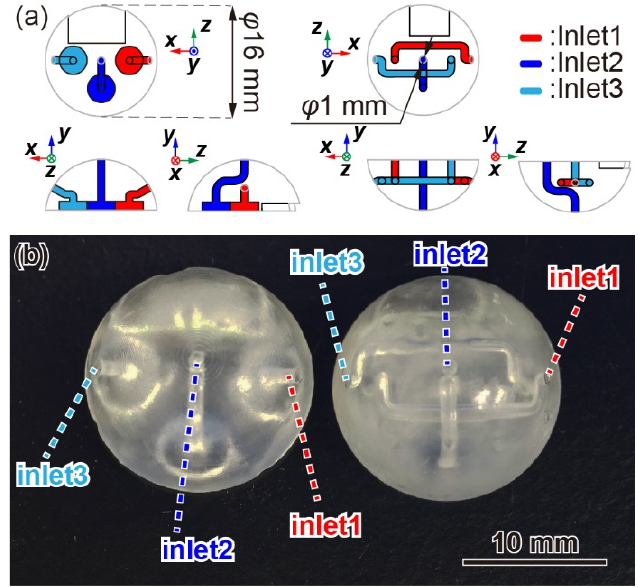
Figure 4. ( a ) Design of the sensor housing with inlets and airflow channel. ( b ) Photograph of the housing fabricated by a 3D printer.